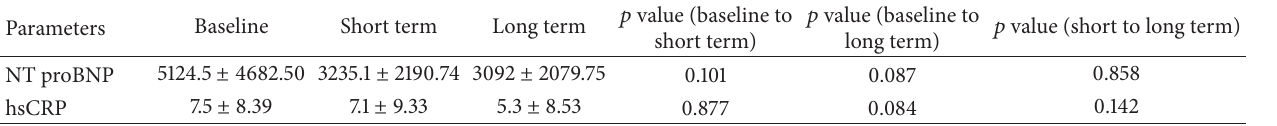
Table 4: Laboratory parameters.